Question: Give a one-sentence summary of this figure.
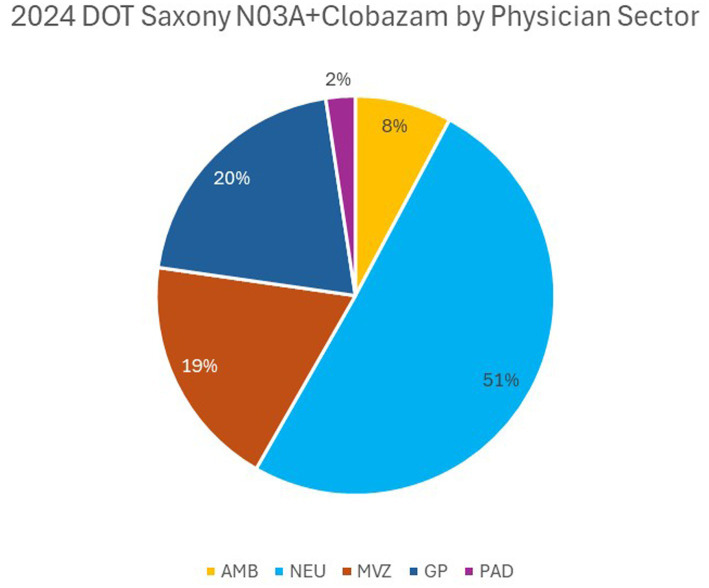
Answer: Distribution of Epilepsy treatment Volume Across Physician Sector in Saxony 2024 by DOТ Distribution of epilepsy treatment volume across physician sectors in Saxony (2024). Treatment volume was calculated using aggregate days on therapy (DOT) for all antiseizure medications classified within the ATC NO3A category, supplemented by clobazam. A total of 19,220,850 DOT were identified across the 11 Saxony districts. Neurologists accounted for 51% of treatment volume, followed by general practitioners (20%), medical care centers (MVZs; 19%), hospital outpatient clinics (AMB; 8%), and pediatric providers (2%). DOT was used as a measure of longitudinal treatment volume rather than patient counts.